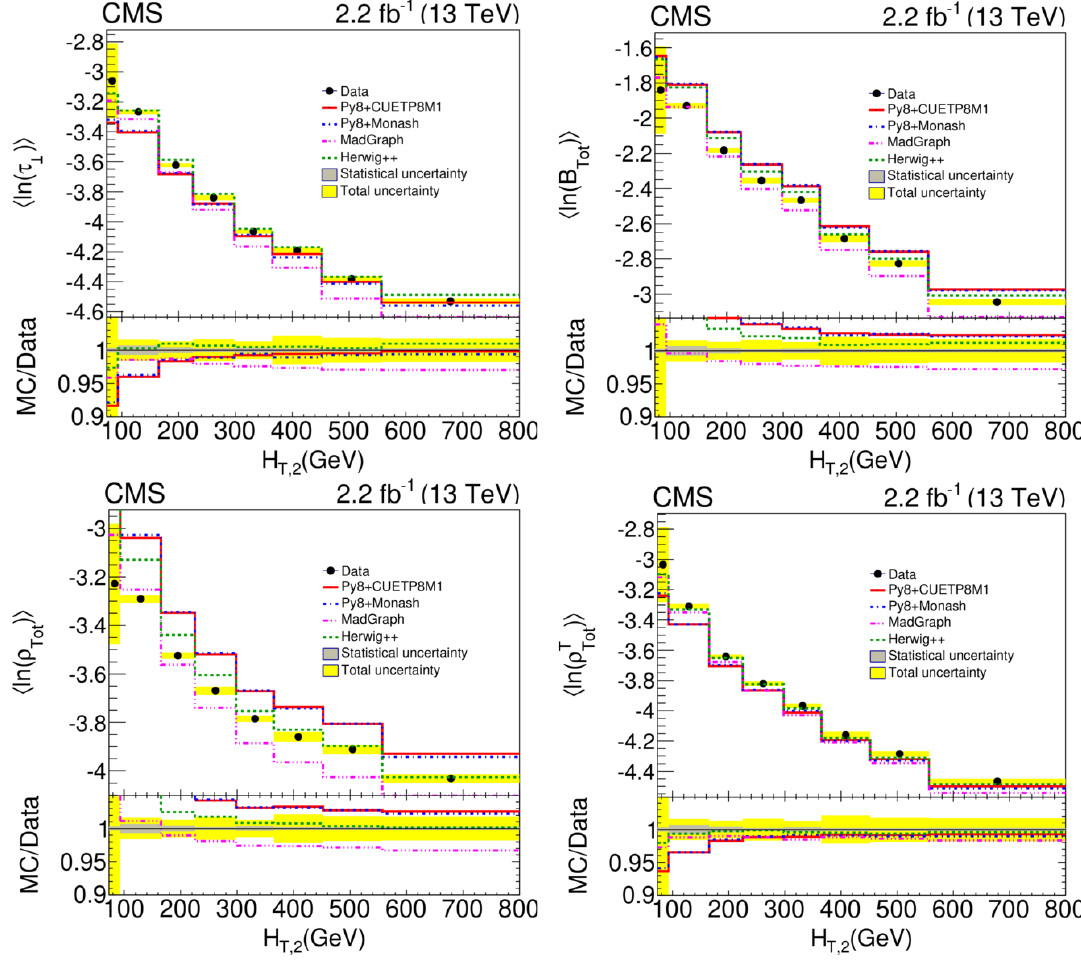
Figure 11 . The evolution of the mean of (cid:28) ? (upper left), B Tot (upper right), (cid:26) Tot (lower left) and (cid:26) T (lower right) and with increasing H T ; 2 . The ratio plots with respect to data are presented in the Tot bottom panel to compare predictions of pythia 8 CUETP8M1 (red line), pythia 8 Monash (blue dash-dotted line), MadGraph 5 a mc@nlo (pink dash-dot-dotted line) and herwig++ (brown dash-dot-dotted line). The yellow band represents the total uncertainty (systematic and statistical components added in quadrature).